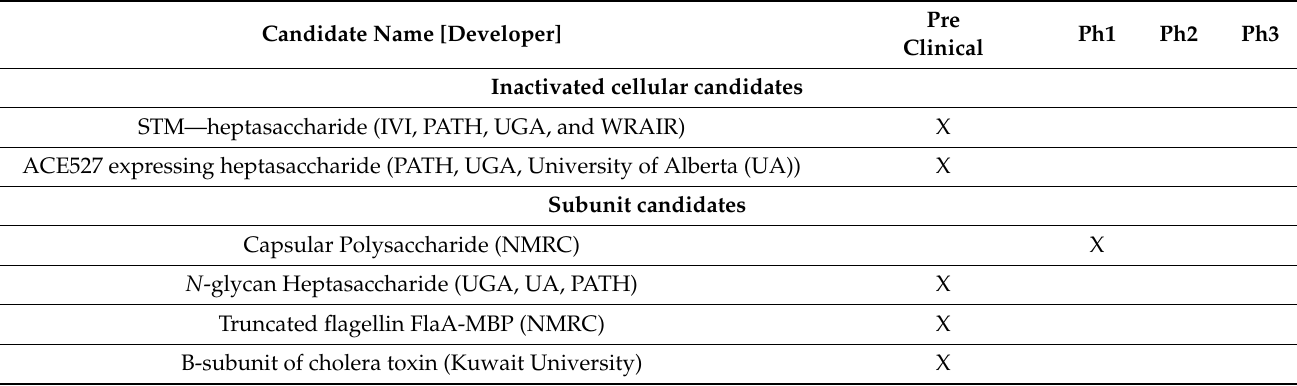
Table 3. Campylobacter vaccine candidates (in development or previously found